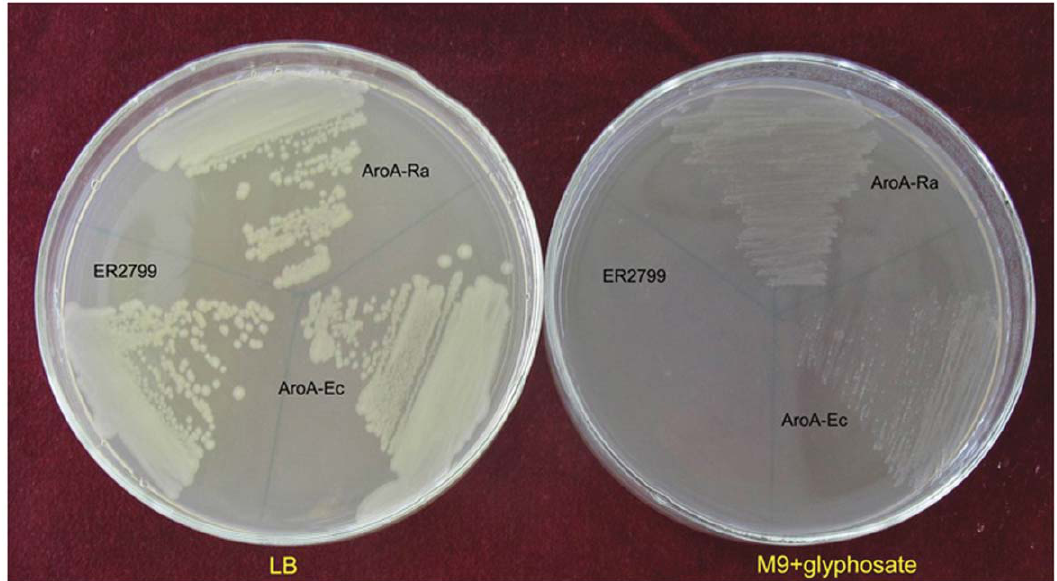
Figure 1. Functional analysis of the aroA gene of R.aquatilis G20. In vivo complementation of the E. coli aroA mutant strain ER2799 by the constructs of the AroA fragments. The strain harboring pYPX251, p251-AroA-Ra, and p251-AroA-Ec were tested for growth on LB or M9 minimal medium agar plates with 60 mM glyphosate.